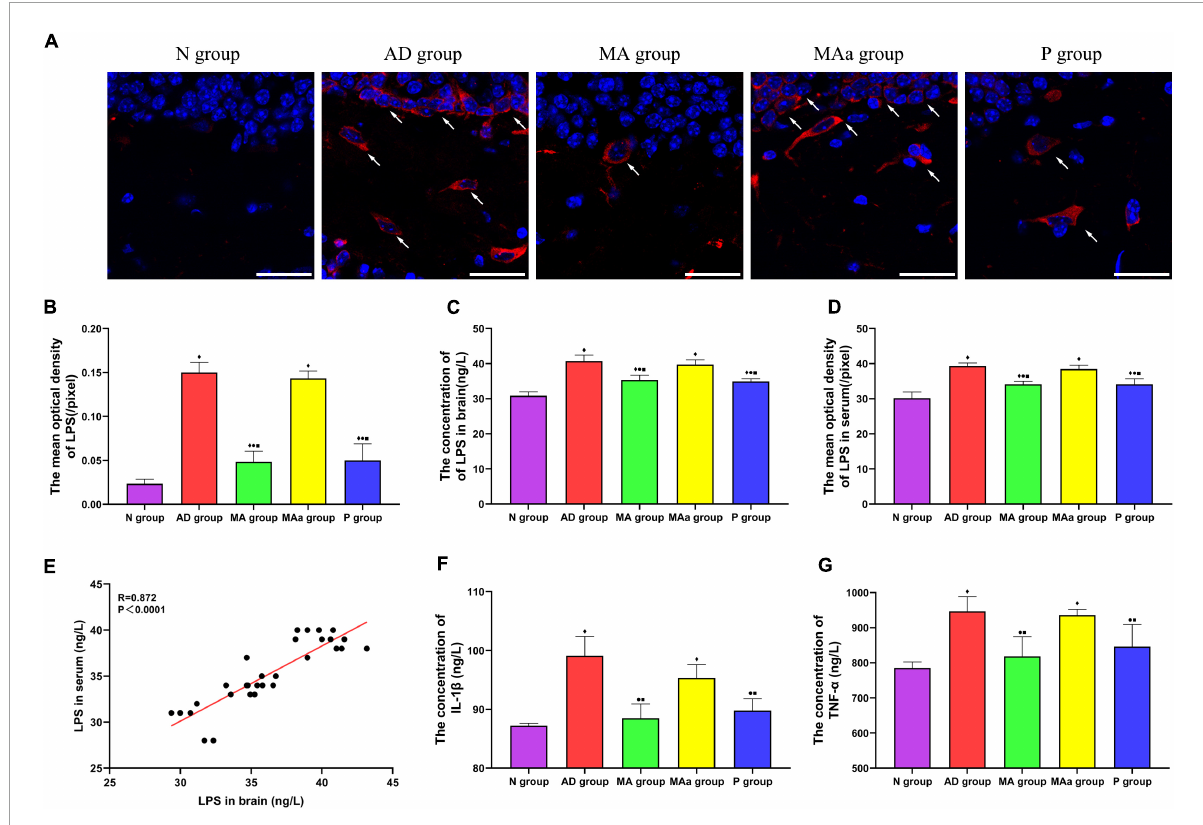
FIGURE5 Results of LPS and inflammatory factor levels in each group ( n = 6, mean ± SD). (A) Representative images of IF staining of LPS in each group. LPS is labeled with red fluorescence. The nucleus is labeled with blue fluorescence. Scale bar is 50 µ m. (B) Comparison of the mean optical density of LPS in each group. (C,D) Comparison of LPS in serum and brain of all groups. (E) Pearson correlation analysis of LPS between brain and serum. (F,G) Comparison of serum TNF- α and IL-1 β in all groups. Compared to the N group, (cid:7) p < 0.01 or p < 0.05. Compared to the AD group, • p < 0.01 or p < 0.05. Compared to the MAa group, (cid:4) p < 0.01 or p <